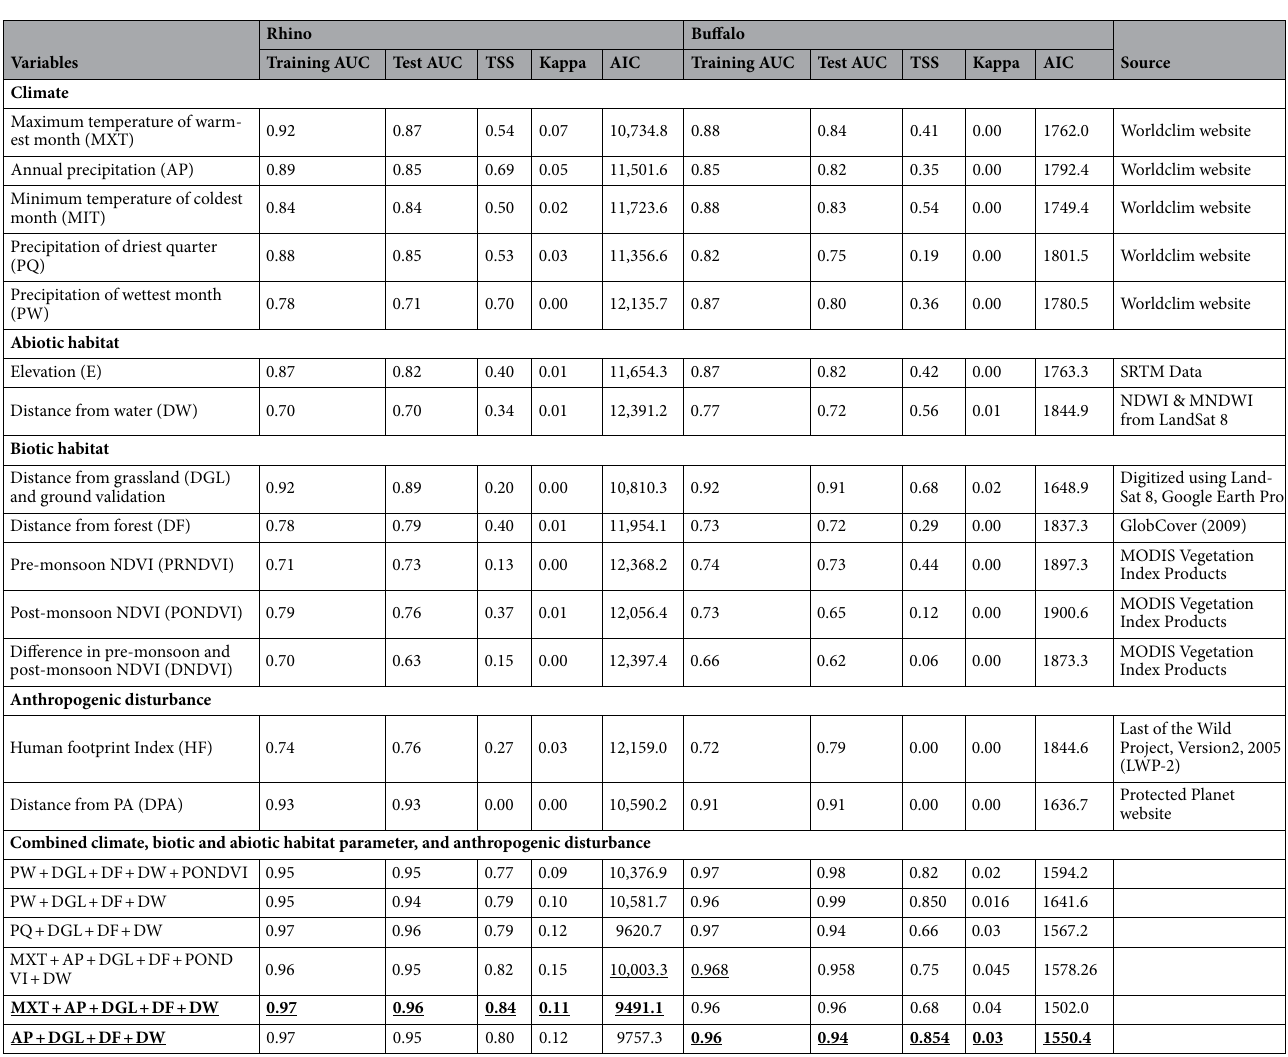
Table 1. Covariates, their contribution to explaining species occurrence, and their sources. Here AUC- Area Under Curve, TSS- True Skill Statistics and AIC- Akaike Information Criteria. The best models (bold